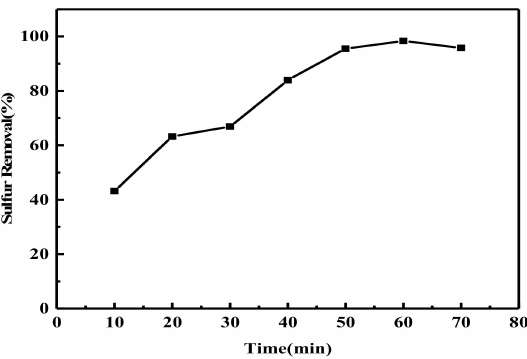
Figure 5. Effect of reaction time on desulfurization. Reaction conditions: V(oil) = 5 mL; n(catalyst)/n(S) = 0.025; n(H 2 O 2 )/n(S) = 6; V(acetonitrile) = 0.5 mL; T = 50 ◦ C.